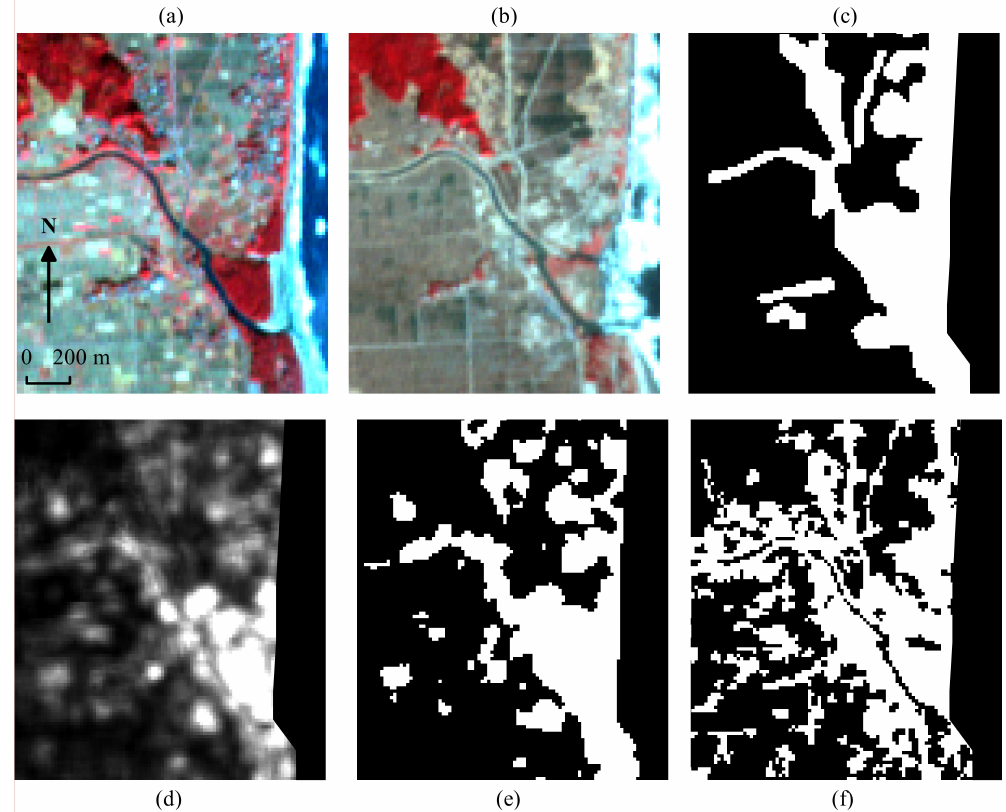
Figure 7. Change detection results. ( a ) image taken on 29 November 2010, ( b ) image taken on 19 March 2011, ( c ) ground truth, ( d ) average RE image of the proposed method, ( e ) proposed method CM, ( f ) RBM.